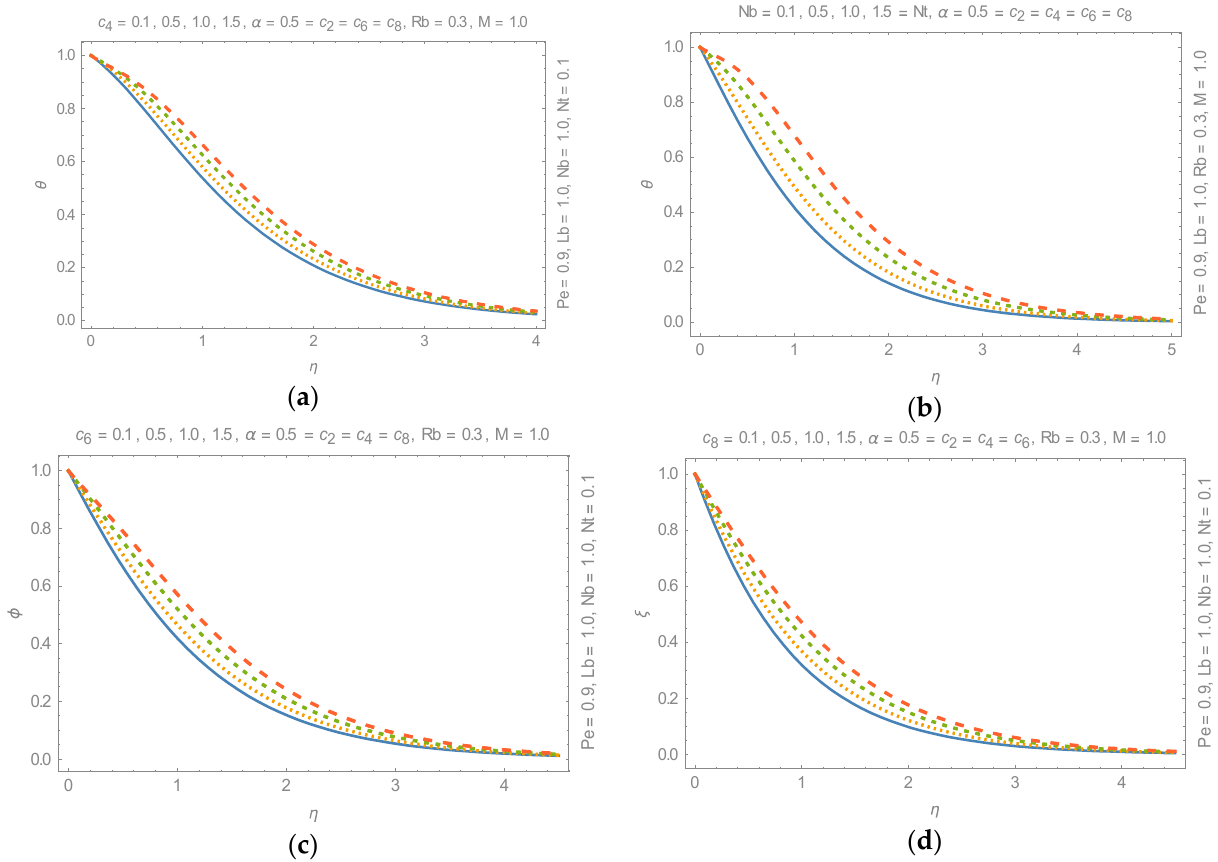
( ) q h ( ) q h ( ) f h ( ) x h Figure 4. Behavior of ( a ) θ ( η ) for c 4 , ( b ) θ ( η ) for Nb , ( c ) φ ( η ) for c 6 , and ( d ) ξ ( η ) for c 8 . Figure 4. Behavior of ( a ) for c 4 , ( b ) for Nb , ( c ) for c 6 , and ( d ) for c 8 . In addition, substantial quantities, e.g., − f (cid:48)(cid:48) ( 0 ) and − g (cid:48)(cid:48) ( 0 ) along x - and y - axes, heat flux − θ (cid:48) ( 0 ) , mass flux − φ (cid:48) ( 0 ) , and local density number − ξ (cid:48) ( 0 ) of motile microorganisms against variation in controlling parameters are estimated and exhibited in Tables 1 and